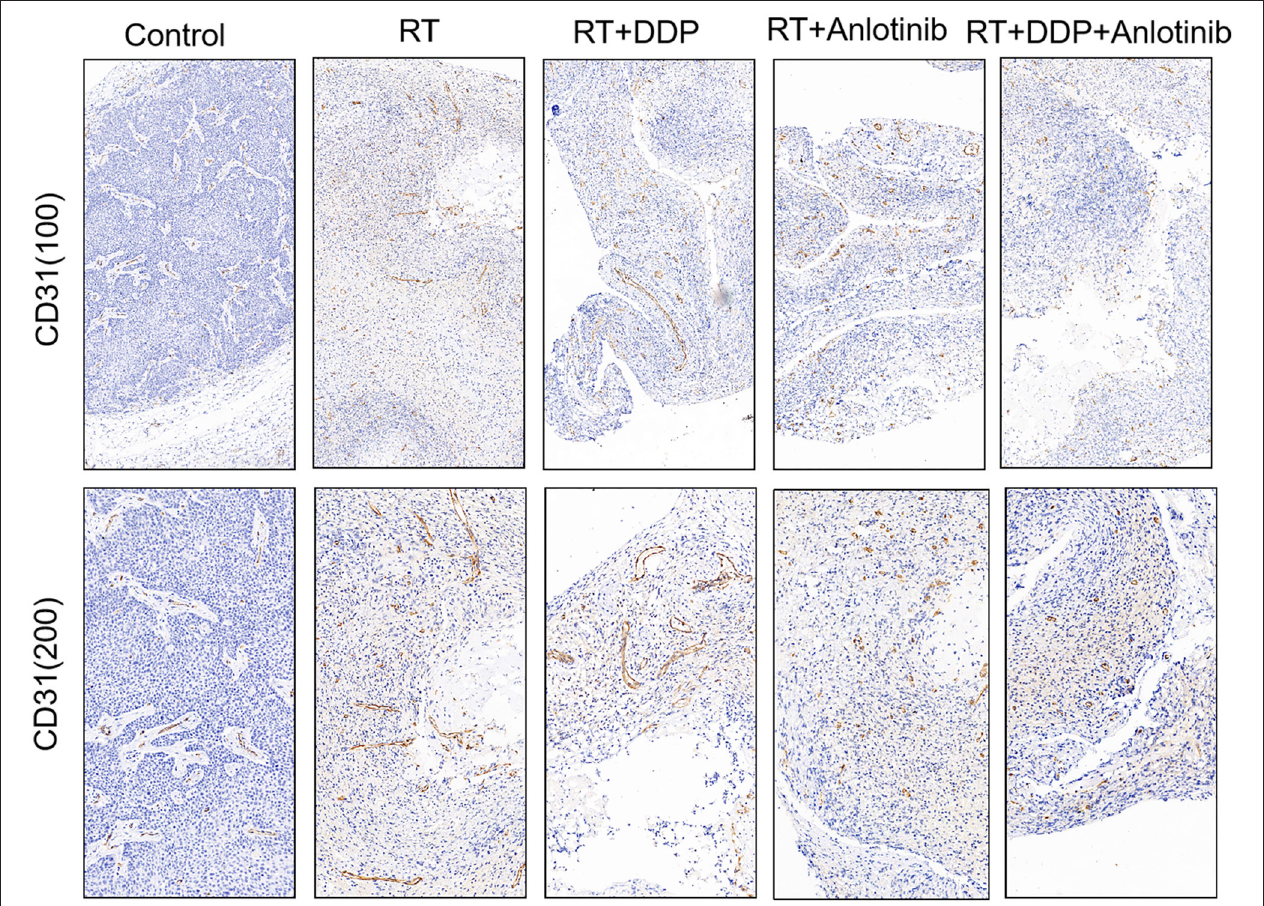
FIGURE 9 | Representative images of changes in the number of vessels showed that the four treatment groups showed different numbers of vessels in which anlotinib combined with chemoradiation-treated group was the lowest compared with the control group. The figure provided is a representative image, and other images are provided in the Supplementary Files. RT, radiation therapy; DDP,